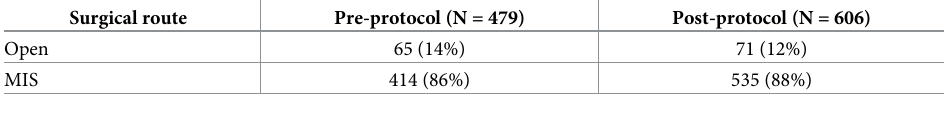
Table 3. Rates of open and MIS surgical routes for hysterectomies and myomectomies combined in pre-and post- protocol cohorts. Surgical route